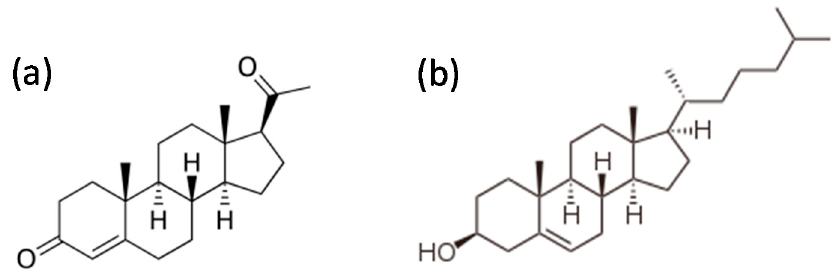
Figure 7. Chemical structures of ( a ) progesterone and ( b ) cholesterol.